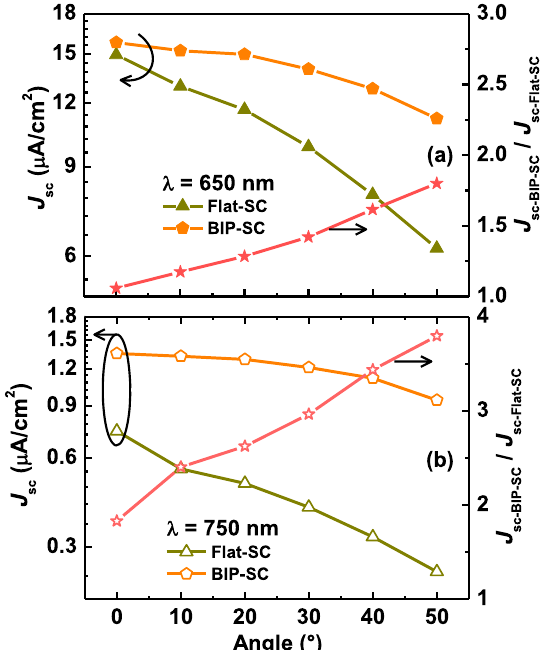
Fig. 7. The J sc angular dependence of the BIP-SC and the Flat- SC devices for two wavelengths of unpolarized light, 650 nm and 750 nm, is shown in the left y -axes of the (a) and (b) parts respectively. The right y -axes of these graphs show the angular dependence of the J sc ratio ( J sc -BIP-SC/ J sc -Flat-SC) for these two wavelengths of